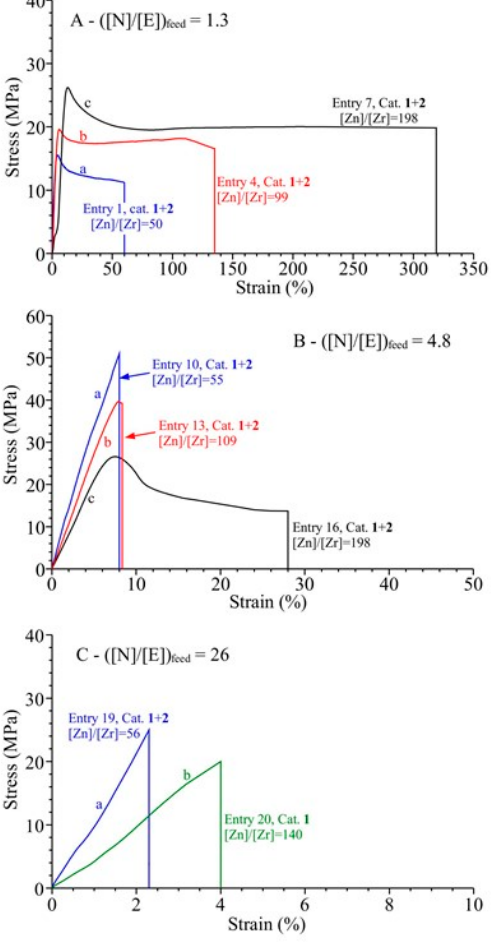
Figure 7. Stress–strain curves of compression molded films of poly(ethylene- co -norbornene) copolymers synthesized with the catalysts 1 , 2 and 1 + 2 , at [N]/[E] feed ratio of: 1.3 ( A ); 4.8 ( B ); and 26 ( C ). The concentration of CTA used in the polymerization is indicated as [Zn]/[Zr] ratio. All samples were stretched at rate v = 0.5 l 0 with l 0 the initial gauge length, with exception of entry 7 in ( A ), which was stretched at rate v = 10 l 0 .